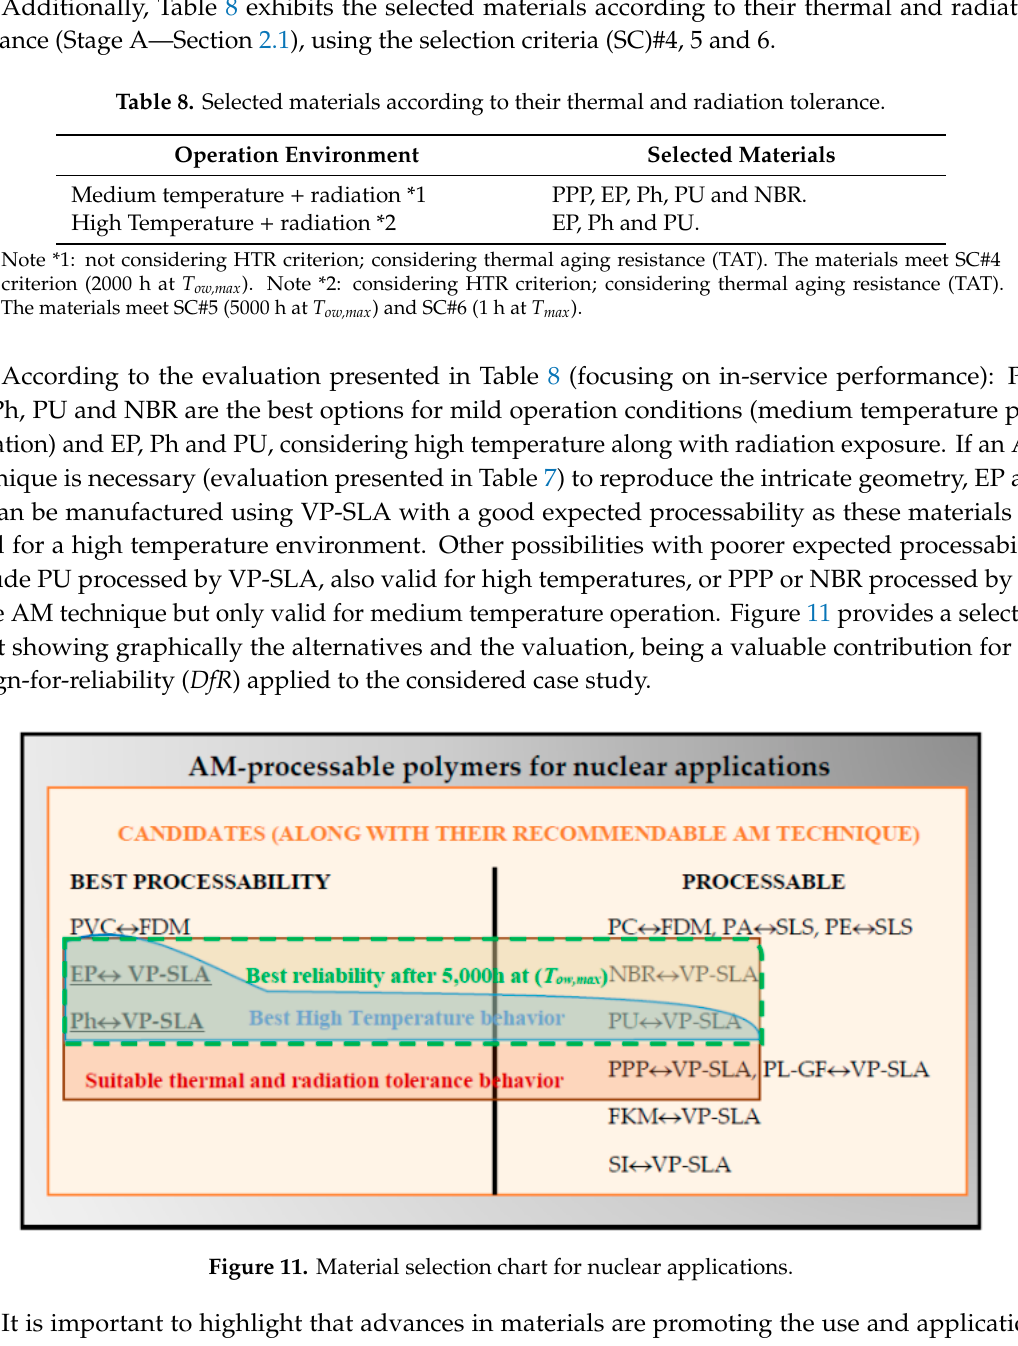
Figure 12. Stringency levels (obtained from selection criteria SC#1 to SC#6). 1